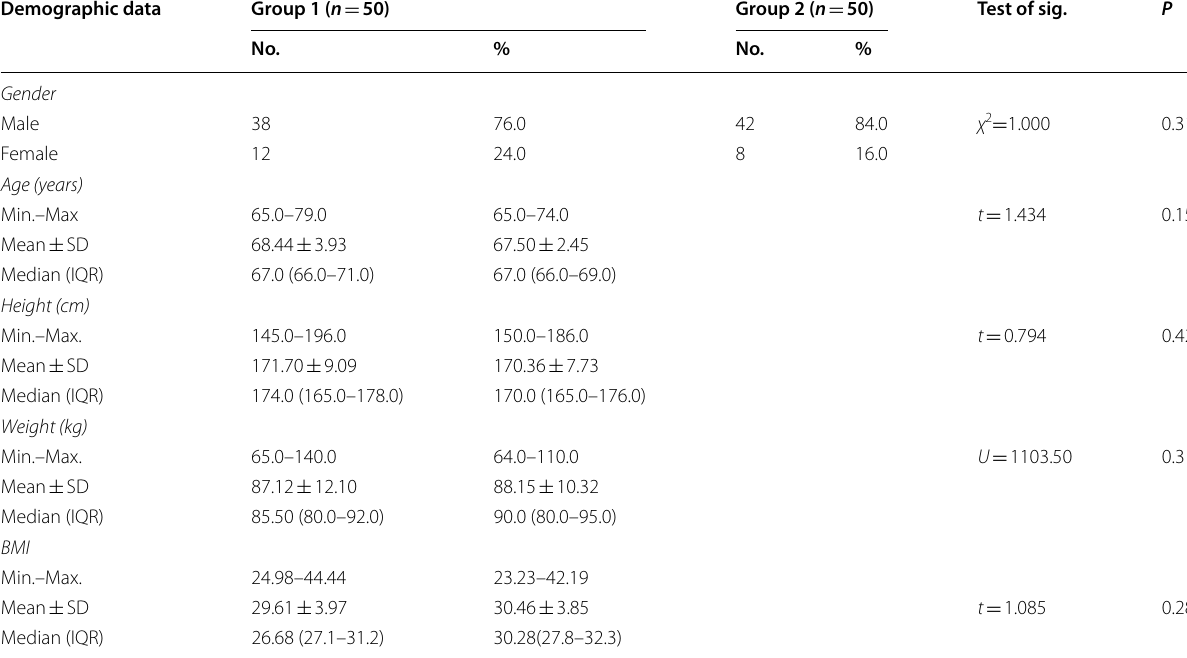
Table 1 Two studied groups compared with reference to demographic data